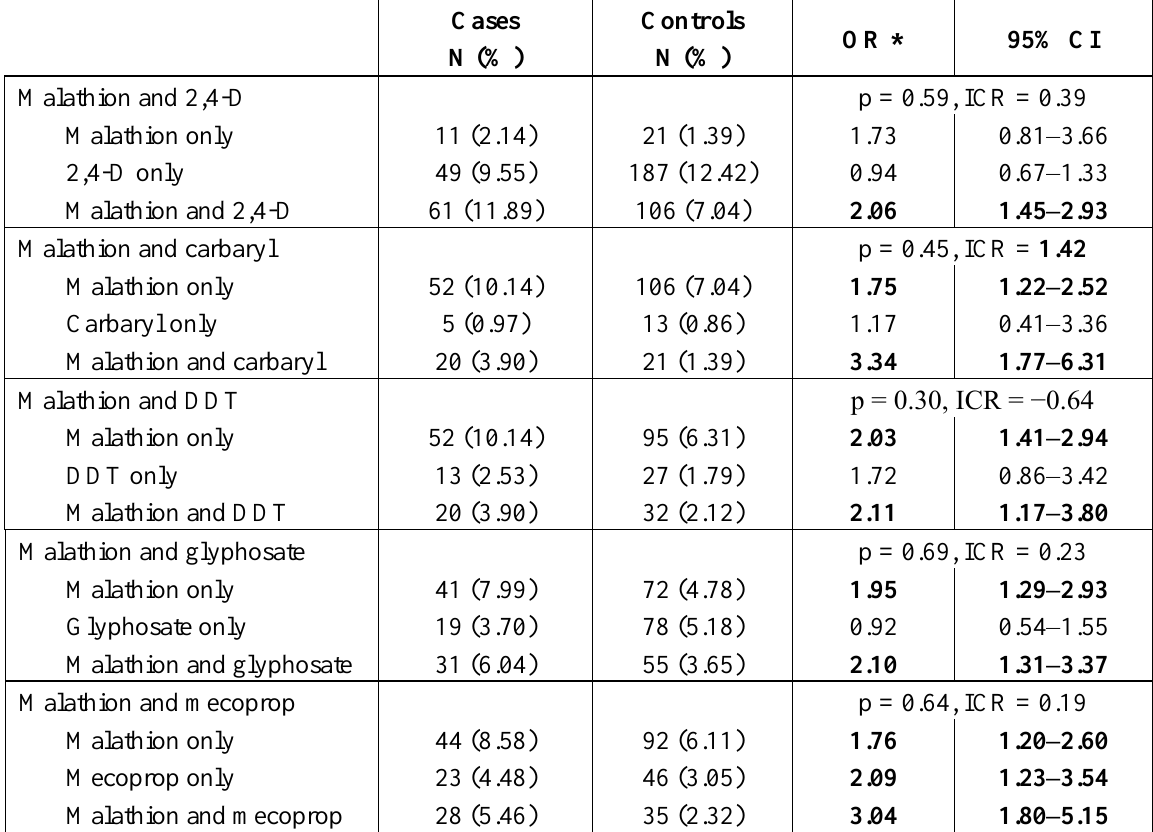
Table 4. Individual and joint effects of commonly used pesticide combinations on